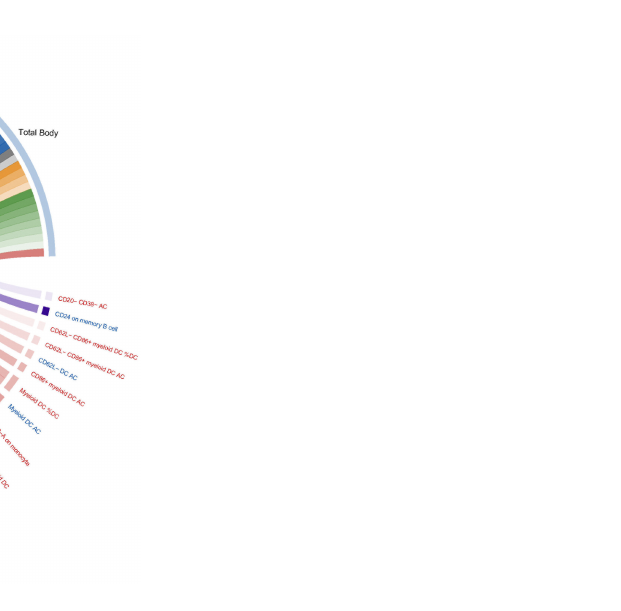
FIGURE 1 Mendelian randomization associations of immune traits (MFI, AC, RC, and MP) on BMDs that derived from the IVW analysis after FDR correction. Immune traits positively associated with BMD are shown in red, while those negatively associated with BMD are shown in blue. IVW, inverse-variance weighted; BMD, bone mass density; MFIs, median fl uorescence intensities; AC, absolute count; RC, relative count; MP, Morphological parameter; FDR, the false discovery